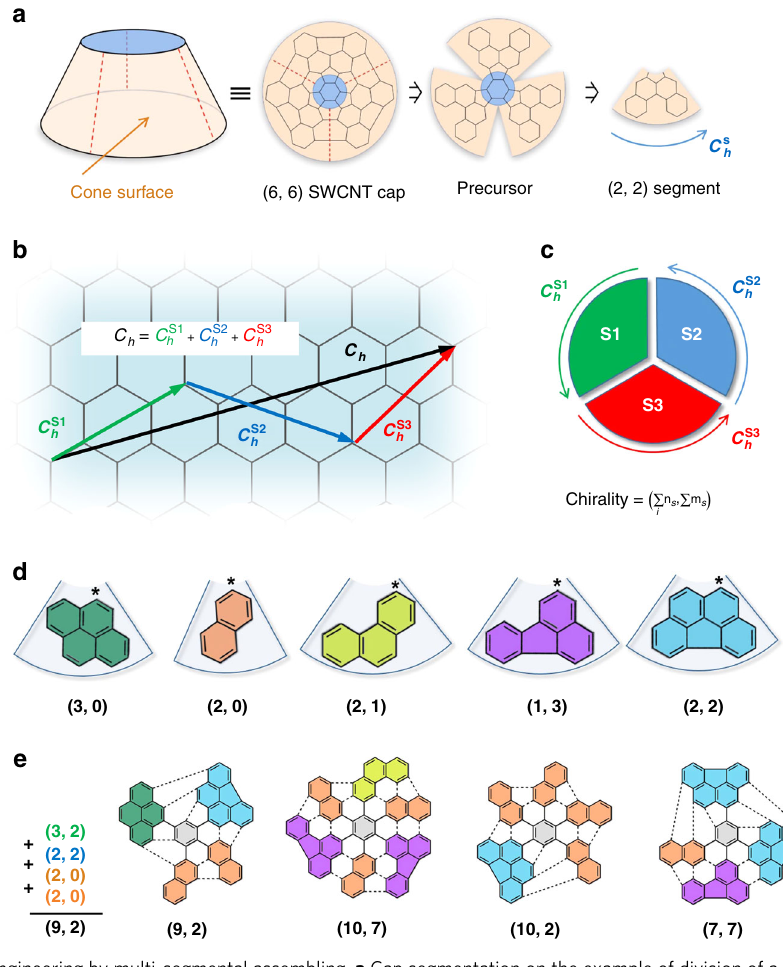
Fig. 2 Concept of end-cap engineering by multi-segmental assembling. a Cap segmentation on the example of division of a (6,6) CNT cap into three equal (2,2) segments; b Determination of the chirality of SWCNT cap with the help of vectors; c schematic representation of contribution of segmental chirality vectors to the fi nal vector C h ; d several possible complimentary segments displayed with their segmental chirality, the asterisk indicates the attachment position to the central branching unit; e examples of multi segmental assembly of CNT caps with various chiralities. Note, that PAH structures shown are not suitable as SWCNT precursors because of the conformational mobility of segments. Required rigidity can be achieved by additional inter-segmental connections which are not shown here for